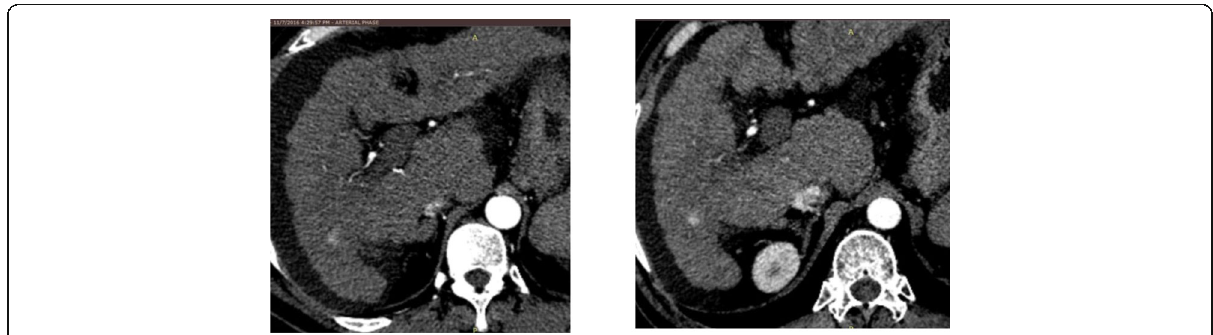
Fig. 5 Case 2: a 63-year-old male patient with cirrhosis. a MDCT in the arterial phase dated January 2017 reveals a small right hepatic lobe segment VI hyper-enhancing nodule measuring 8mm showing no washout in the venous nor the delayed phases (not shown); this lesion is categorized as LIRADS-3. b MDCT in the arterial phase for the same patient 6months later showing stationary size of the